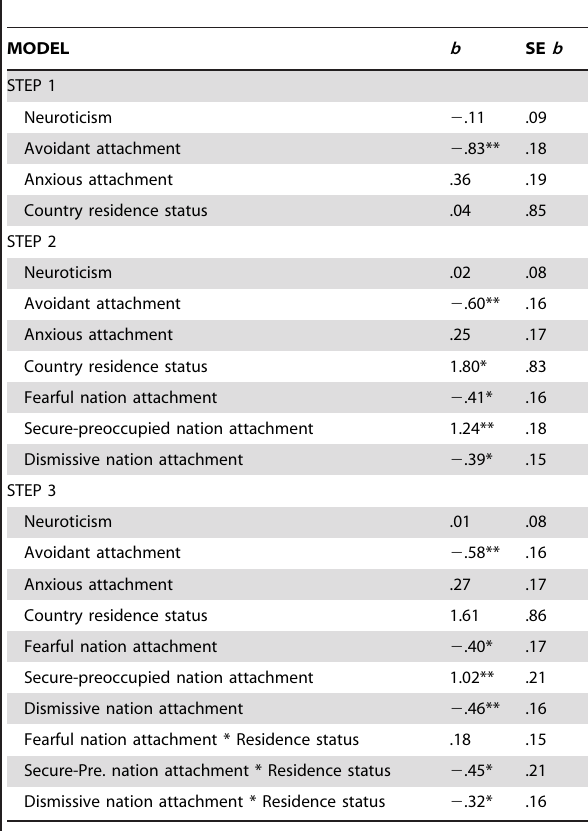
Table 3. Association of Nation Attachment with Heritage Culture